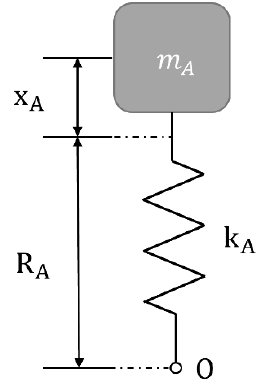
Figure 7. The force on the push piece.